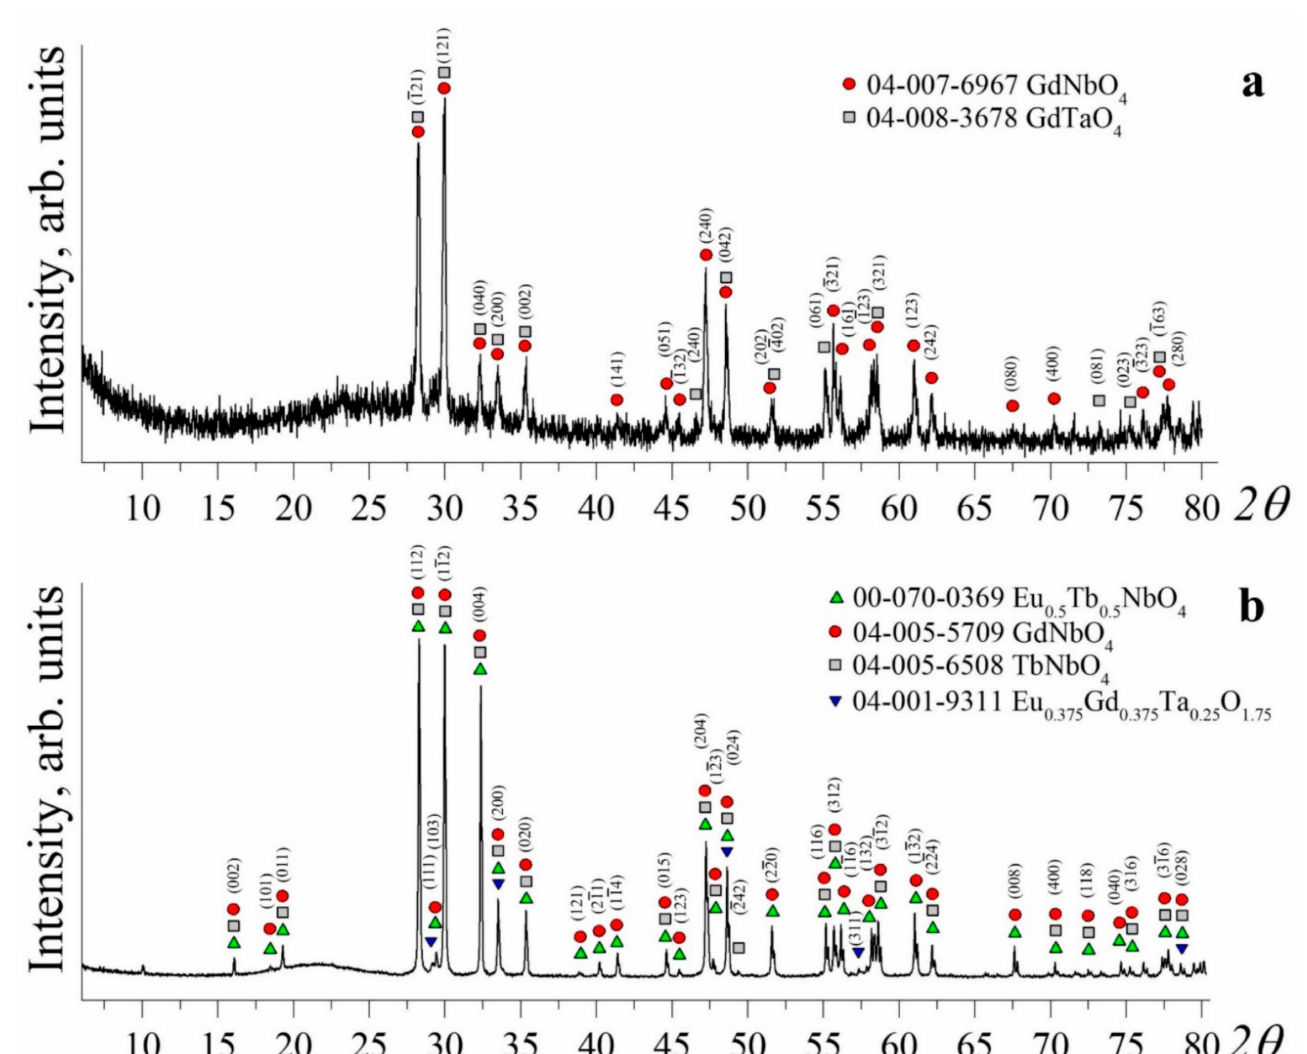
Figure 1. XRD patterns of Gd 0.96 Eu 0.01 Sm 0.01 Tb 0.01 Er 0.01 Nb 0.9 Ta. 0.1 O 4 ceramic samples with the refinement of probable phases. ( a ) Sample 2: • —reflections corresponding to the monoclinic phase of GdNbO 4 with the I2/a space group (ICDD Card 04-007-6967); (cid:4) —reflections corresponding to the monoclinic phase of GdNbO 4 with the C2/c space group (ICDD Card 04-008-3678). ( b ) Sample 4: (cid:78) —reflections corresponding to the monoclinic phase of (Eu 0 . 5 Tb 0 . 5 )NbO 4 with the I2/b(15) space group (card 00-070-0369); • —reflections corresponding to the monoclinic phase of GdNbO 4 with the C2/c space group (card 04-005-5709); (cid:4) —reflections corresponding to the monoclinic phase of GdNbO 4 with the C2/c(15) space group (card 04-005-6508); (cid:72) —reflections corresponding to the cubic phase Eu 0 . 375 Gd 0 . 375 Ta 0 . 25 O 1 . 75 with the Fm-3m (225) space group (Card